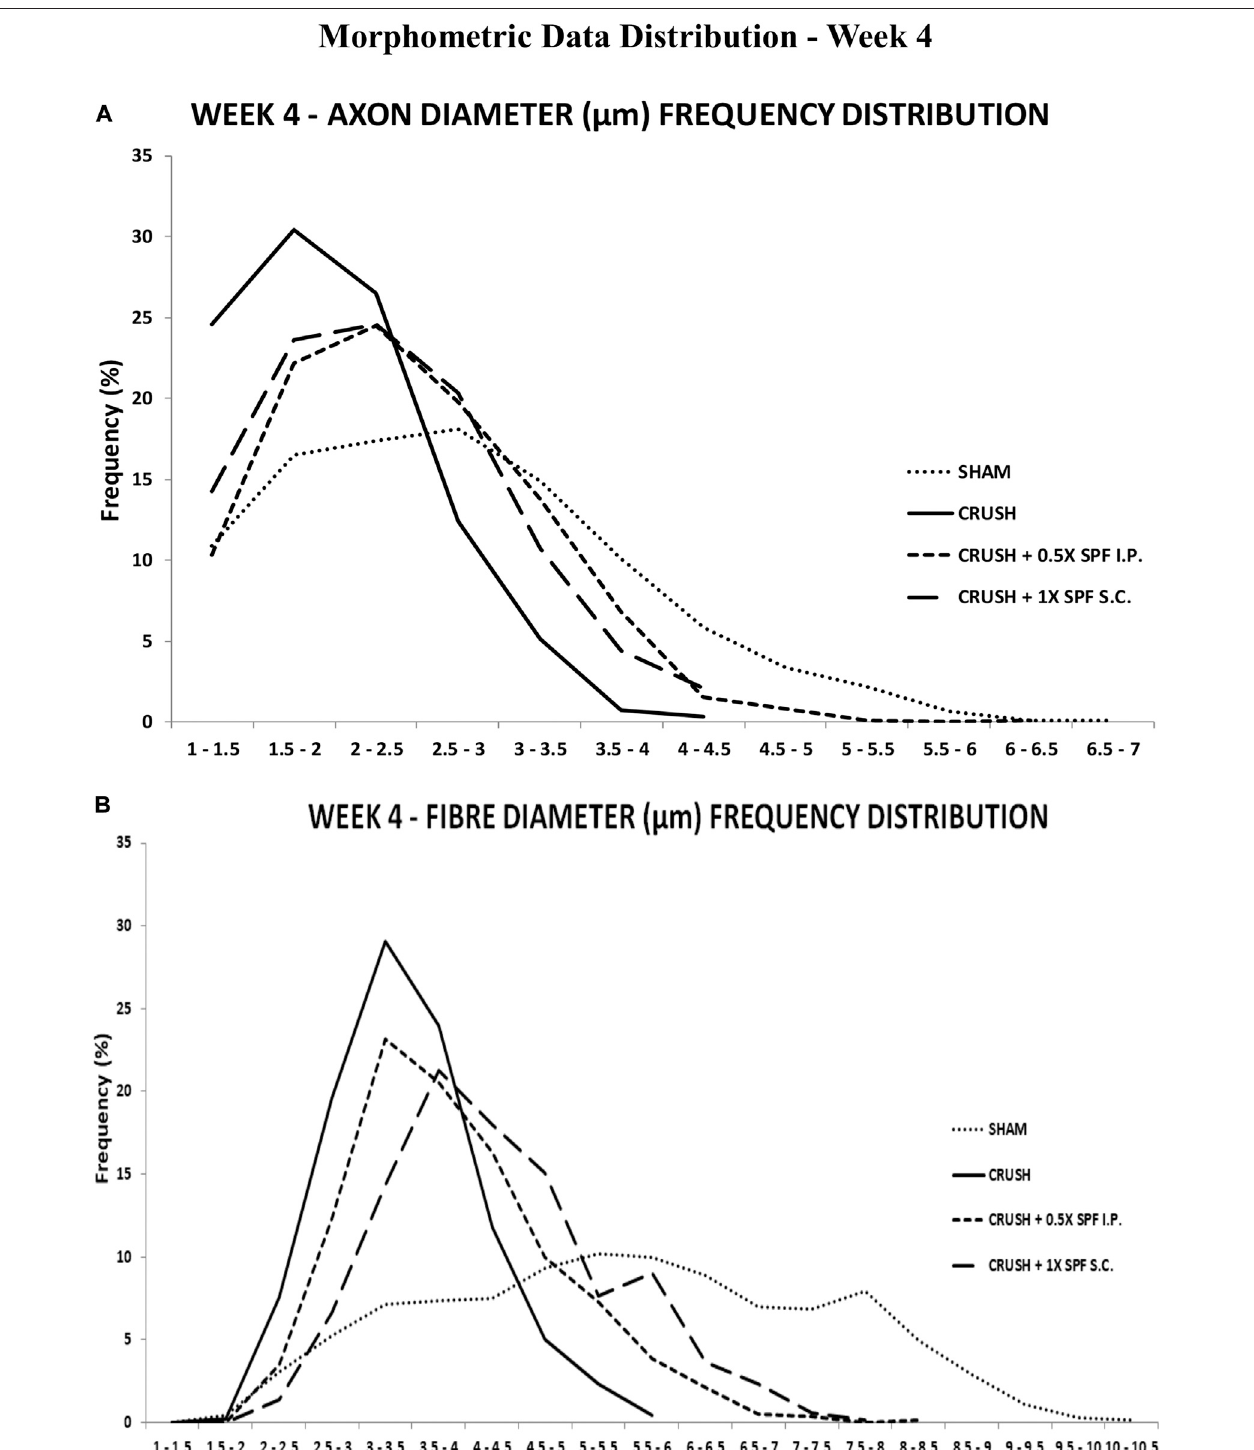
FIGURE 6 | The percentage frequency of the myelinated axons ( A,C ) and nerve fi bers ( B,D ) ( y -axis) were plotted against the diameter sizes ( x -axis) ranging from 1µmto10.5 µmfromtheexperimental.TheCRUSHgroupdisplayedaremarkableshiftinthedistributionoftheaxonandnerve fi berdiametersizestothelefttowardthe lowrangevaluescomparedtoSHAManimalsatweek4andweek6.Althoughthetreatedgroupsshowedanimprovementpatternoftheaxonandnerve fi berdiameters distribution, the CRUSH + SPF-FB(IP)-treated group displayed more normalization of axon and nerve fi ber diameter distribution compared to the CRUSH + SPF- FB(IP)-treated group at Week 4 and Week